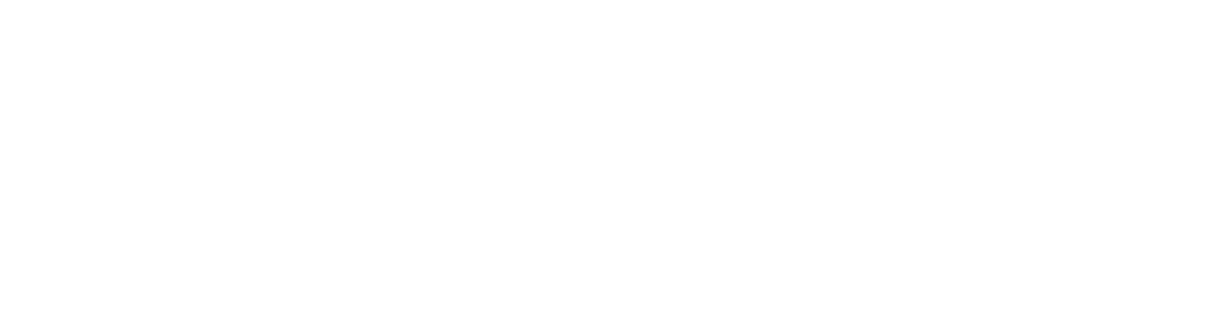
Frontiers in Physics |